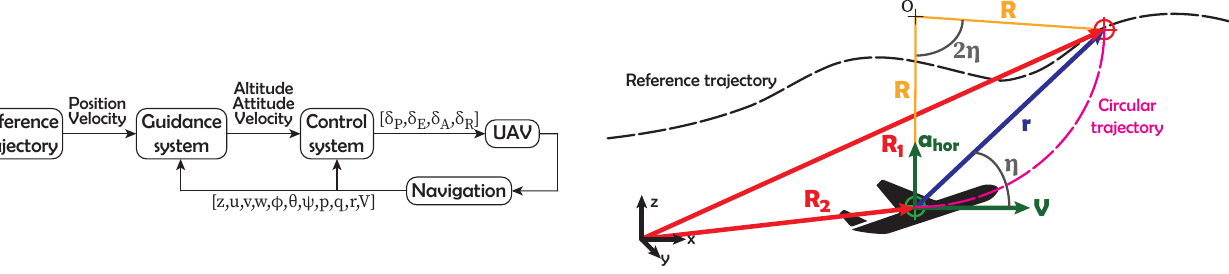
Figure 8. Conceptual guidance system ( left ) and nonlinear guidance law ( right ) schemes. The attitude control cannot accept accelerations; consequently, the horizontal force is translated into a desired course angle ( Ψ ), from which the required yaw angle ( ψ ) that the aircraft must achieve is obtained. At each sampling time ( T s ), a command of the course angle change ( ∆Ψ ) is given. The expression of this angle change is as follows: